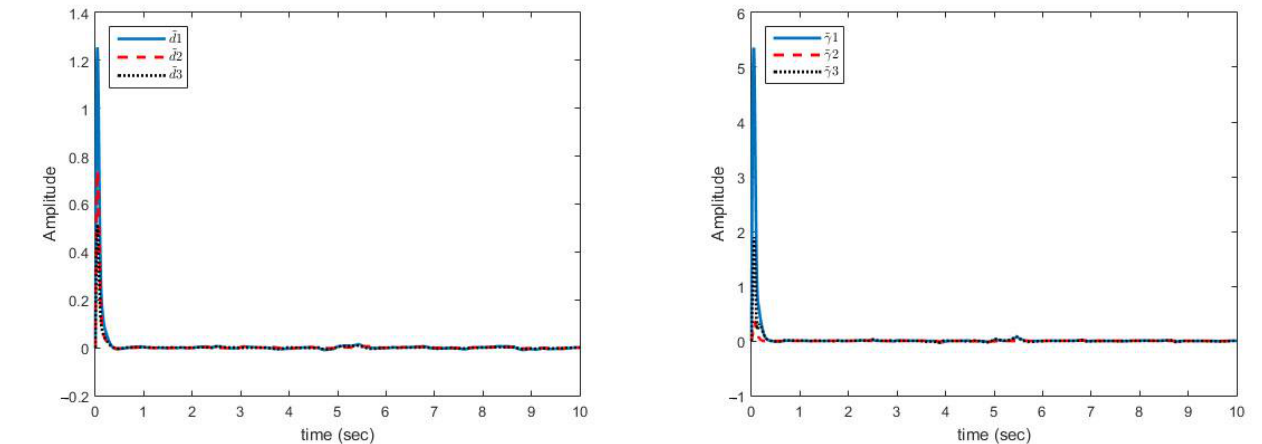
Figure 9. Estimation error curves for uncertainty ( right ) and disturbance ( left ) case (C).